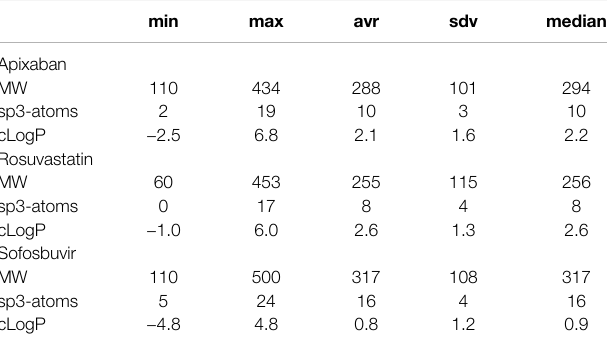
TABLE 1 | Summary of the response values for all datasets. The fi rst column indicates the property and the other columns the minimum, maximum, average, standard deviation, and median values.